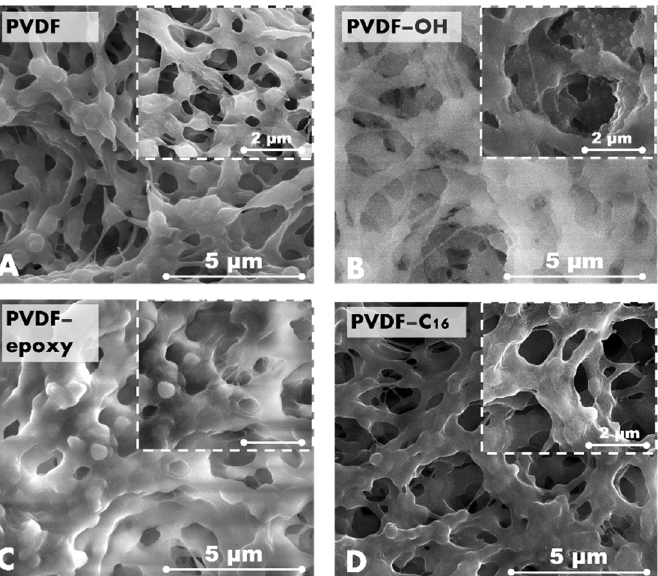
Figure 2. SEM images of pristine ( A ), activated ( B ), and modified samples, PVDF-epoxy ( C ), PVDF- C 16 ( D ). Table 1. Minimum (Min), maximum (Max), and average (Aver) pore size of the investigated membranes with changes relative to the pristine and activated membranes.